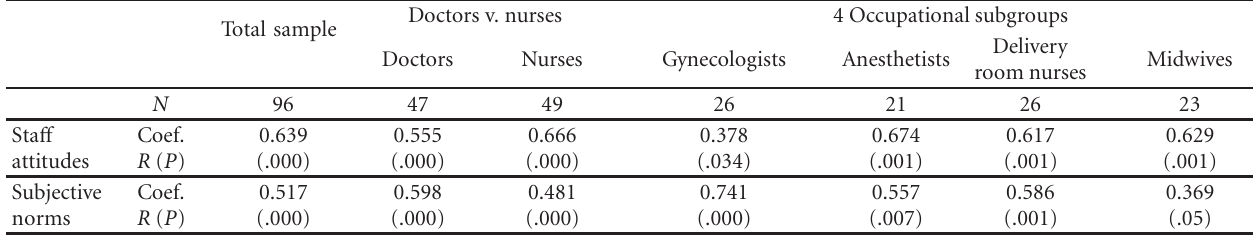
Table 2: Pearson correlation coe ffi cients between sta ff attitudes, subjective norms and behavioral intention.